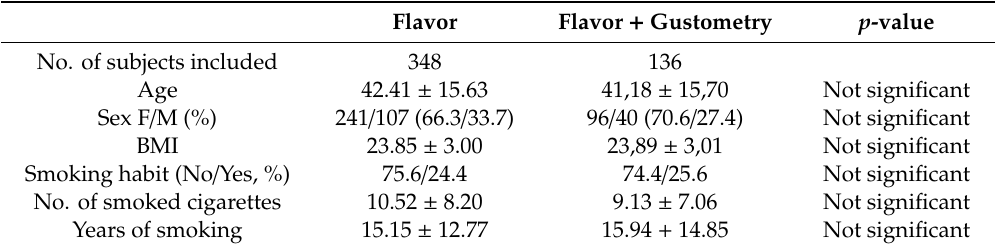
Table 1. Characteristics of the studied population.